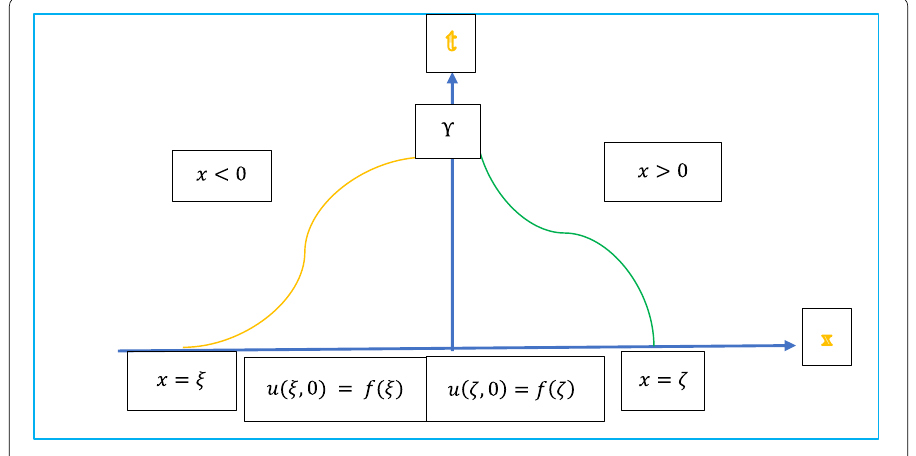
Figure 1 Characteristics curves in the ( x , t